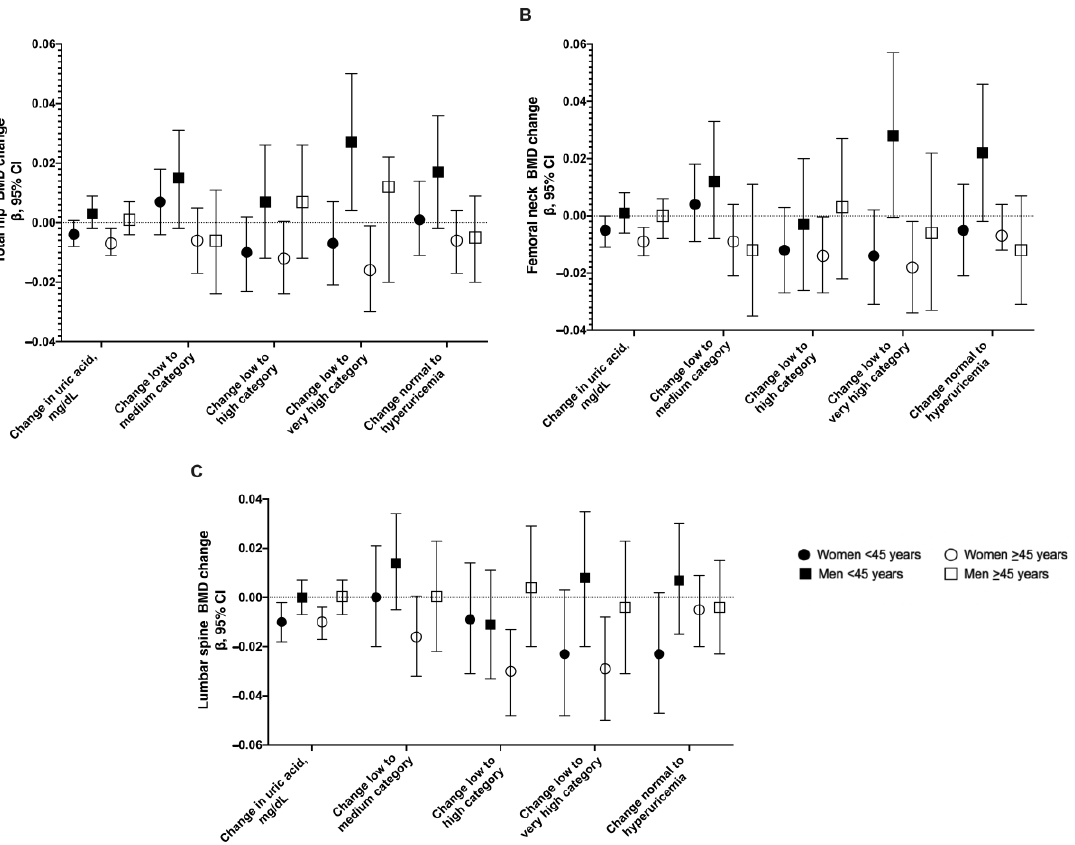
Figure 2. Longitudinal association between changes in UA and changes in total hip BMD ( A ), femoral neck BMD ( B ), and lumbar spine BMD ( C ). Errors bars represent 95% confidence